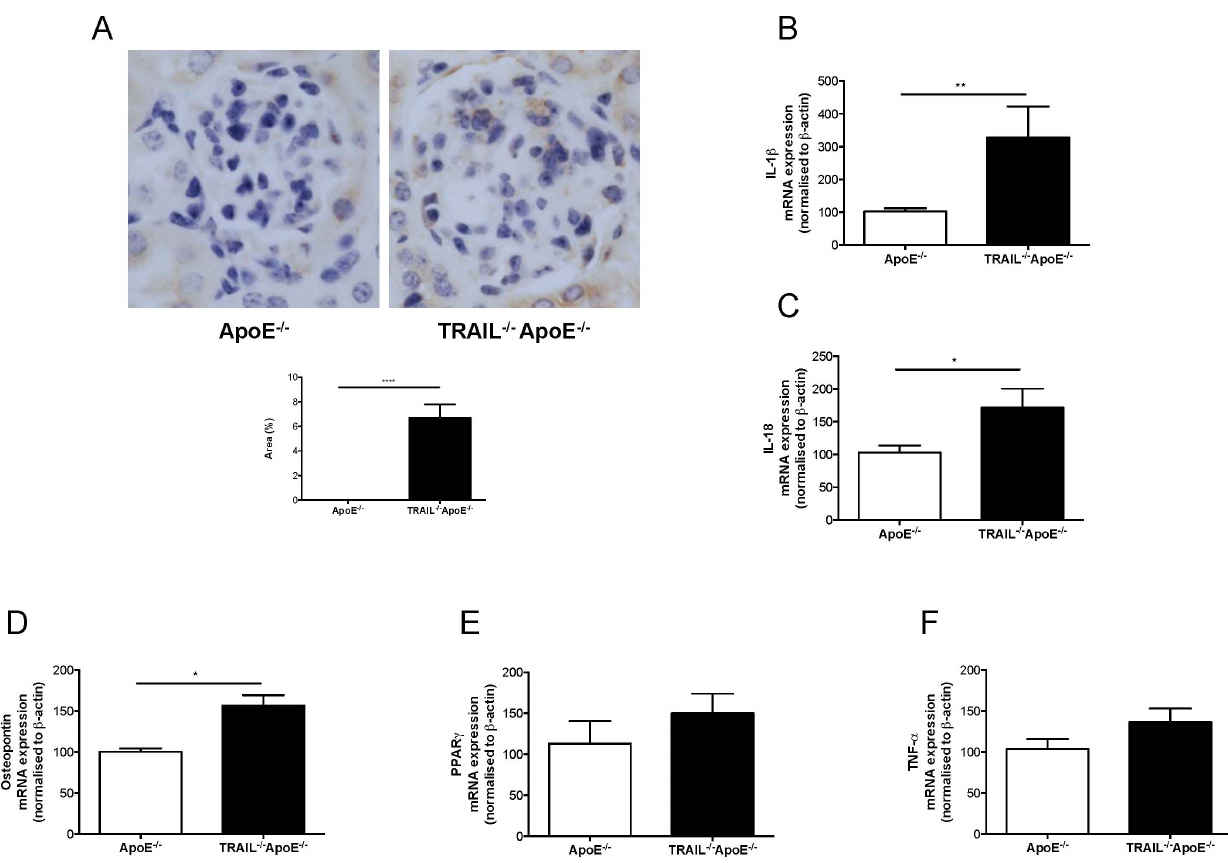
Figure 3. TRAIL -/- ApoE -/- mice have increased macrophage infiltration and genes of inflammation. Representative sections (40X magnification) of mouse kidney after 20 w HFD stained for the pan macrophage marker (a) F4/80. Kidney mRNA expression for (b) IL-1 b , (c) IL-18, (d) osteopontin (e) PPAR- c and (f) TNF- a . All levels were normalized to b -actin; n=5-6/genotype. Results expressed as mean 6 SEM, *p , 0.05, **p , 0.01 and ****p , 0.0001 by Mann-Whitney U test.